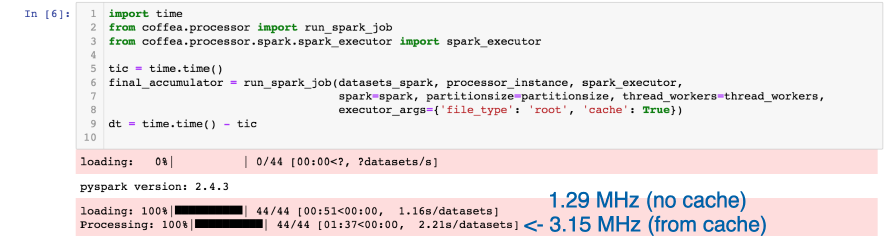
Figure 1. Schema of Laurelin ROOT file’s transformation into Spark DataFrames.